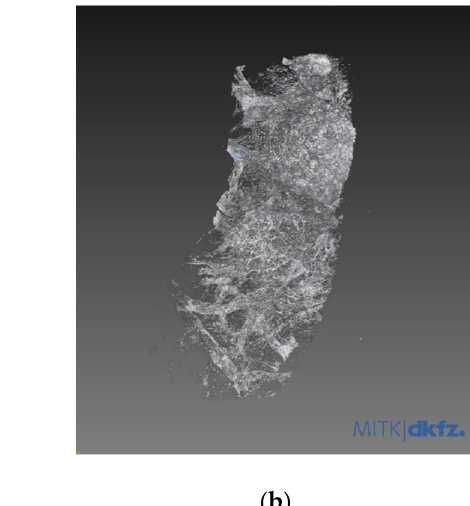
Figure 3. SR tomographic images of lung adenocarcinoma tissue. ( a ) Cross-sectional image of hu- man lung adenocarcinoma tissue. Interstitial thickening and destructed normal alveolar structure including alveolar spaces, interalveolar septa, bronchioles and microvascular structures were ob- served. ( b ) sagittal images of lung adenocarcinoma. Consolidative lesion with no normal structure was identified. Thickened interstitial tissue and narrowed alveolar spaces were noted.